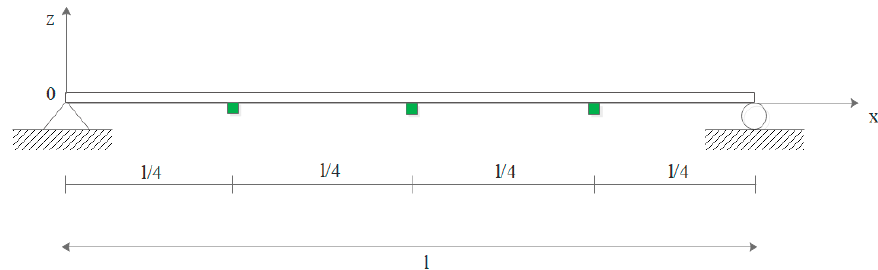
Figure 19. Simply supported beam and sensor locations.